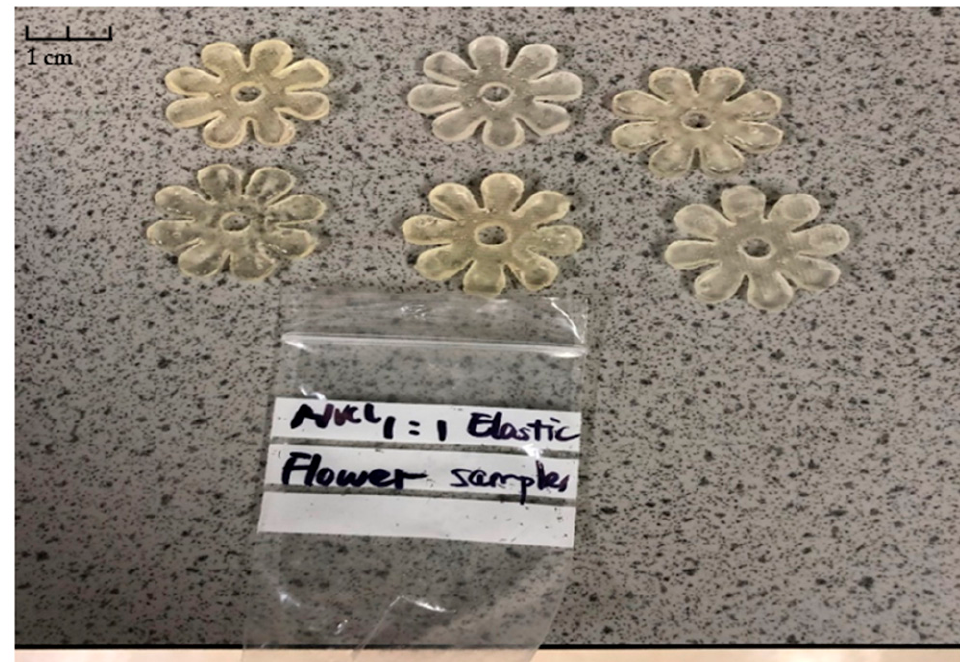
Figure 6. The appearances of bilayer fl ower samples.